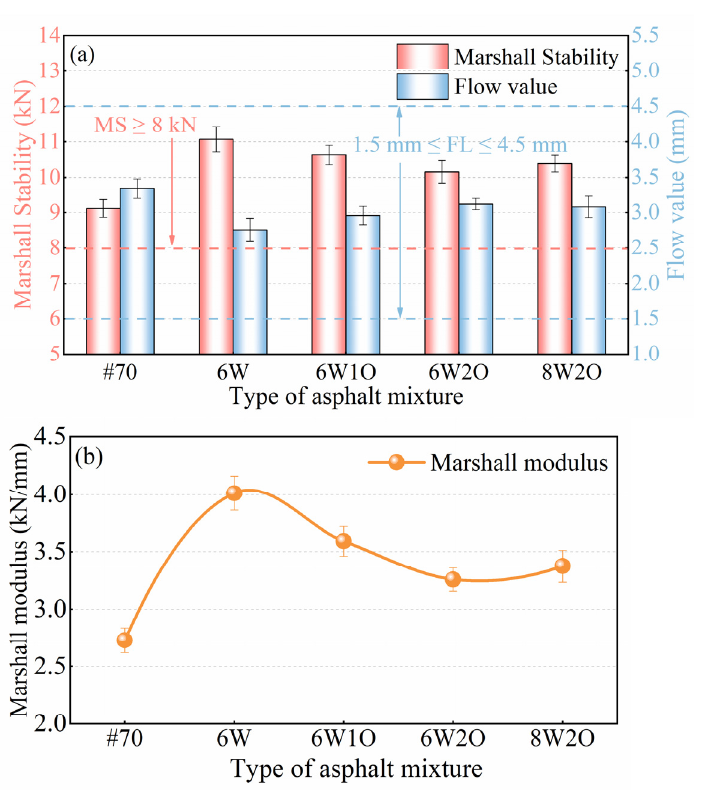
Figure 4. Test results of Marshall stability, flow value, and Marshall modulus. ( a ) Test results of Marshall Stability and flow value. ( b ) Test results of Marshall